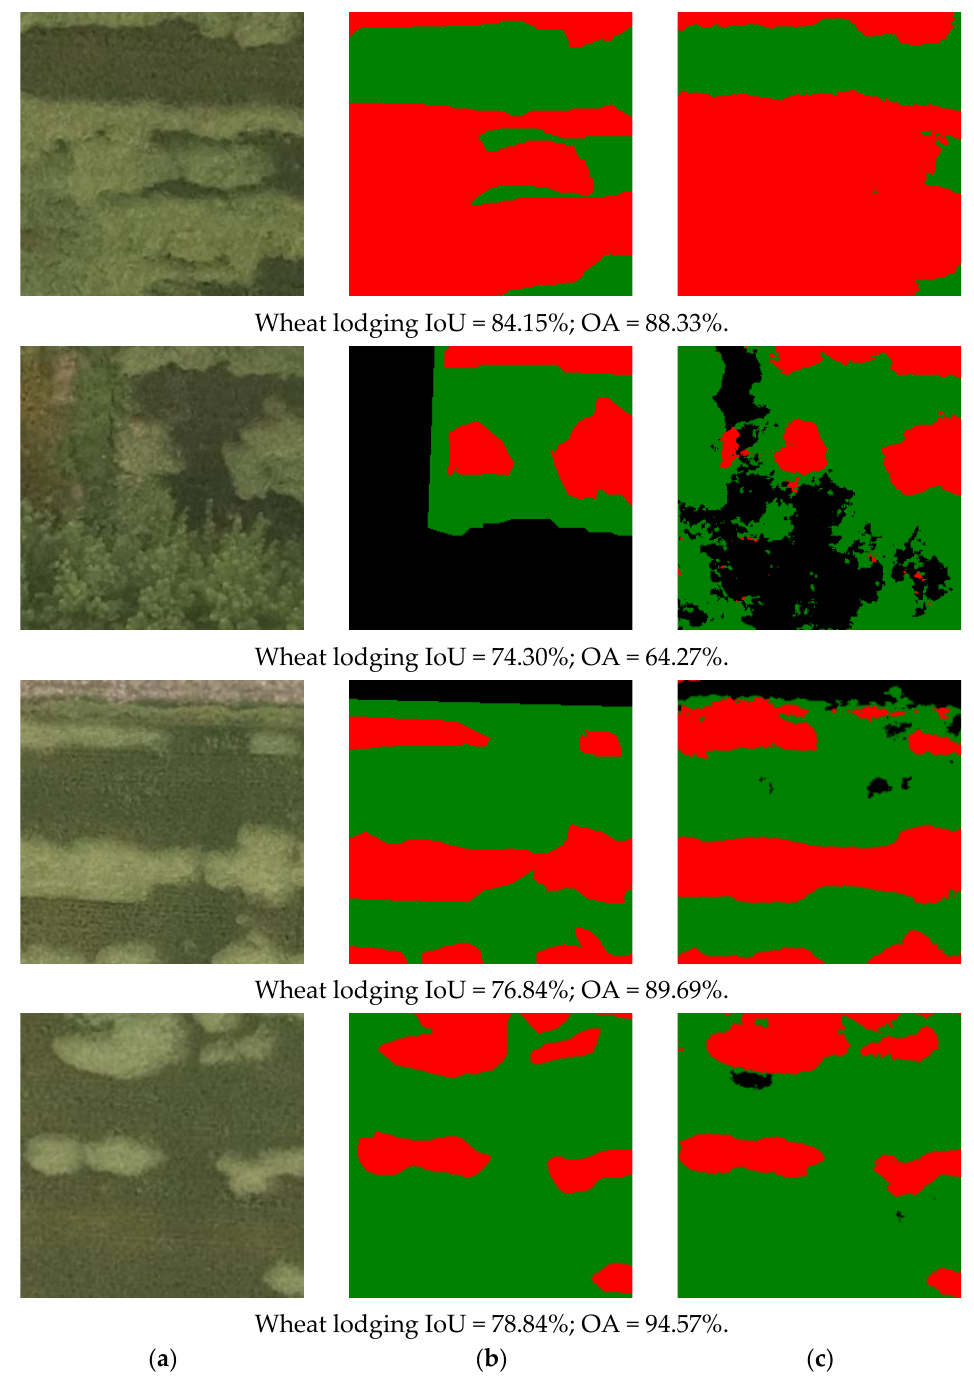
Figure 14. ( a ) Original UAV image; ( b ) ground truth; ( c ) segmentation results from the PTCNet.